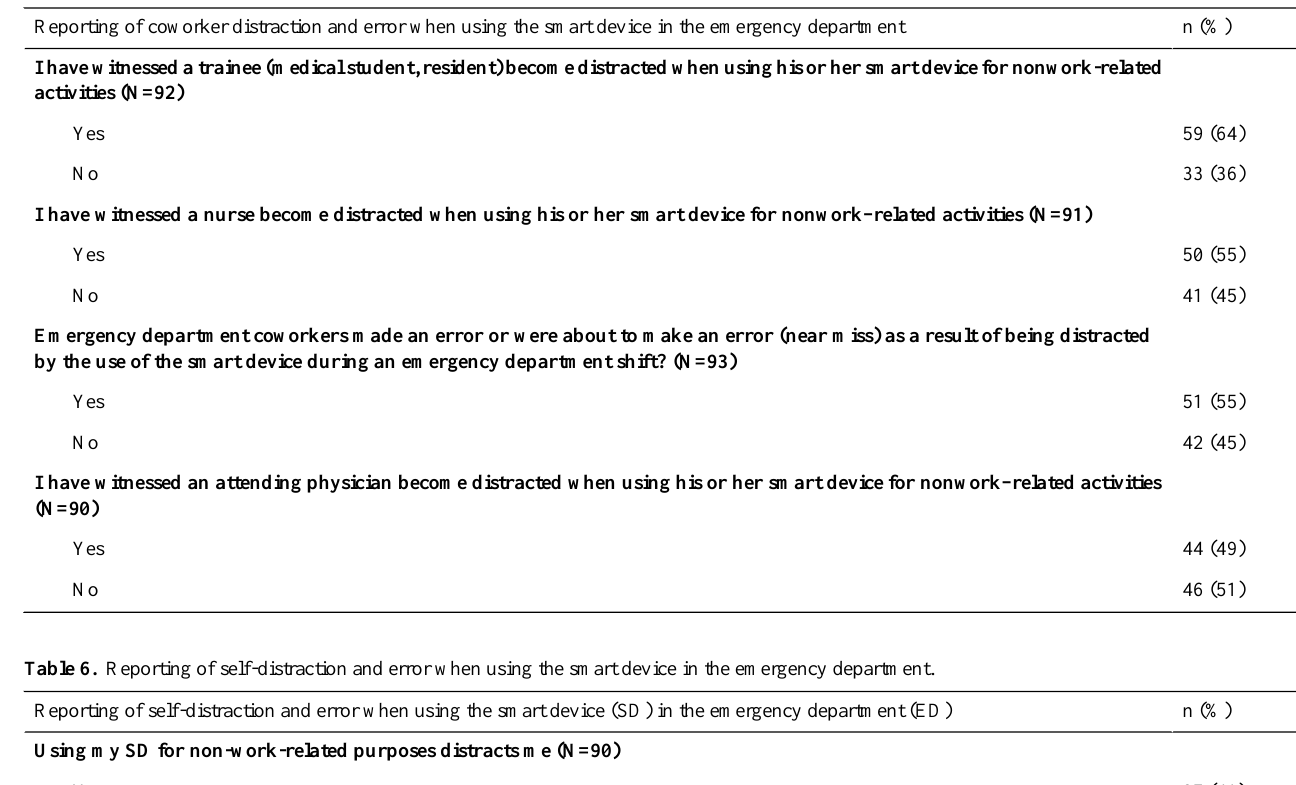
Table 5. Performance in the emergency department when using the smart devices.